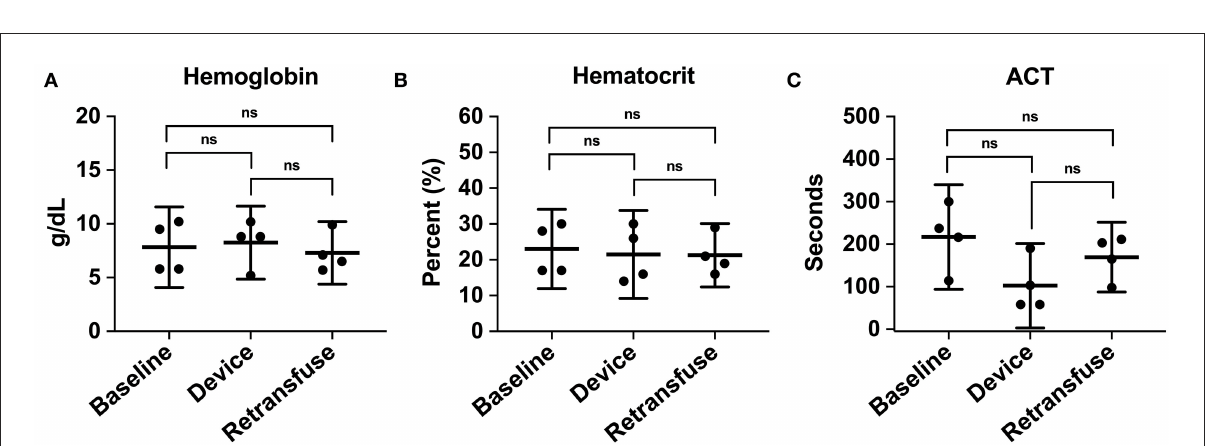
FIGURE7 The hematologic laboratory tests were grouped into samples from the animal at baseline, within the device, and the animal at retransfusion: (A) Hemoglobin at baseline, device, and retransfusion without any significant differences. (B) hematocrit at baseline, device, and retransfusion without any significant differences, and (C) ACT at baseline, device, and retransfusion without any significant differences. The central lines represent the means and the error bars represent the standard deviation. Nonsignificant p -values are presented by